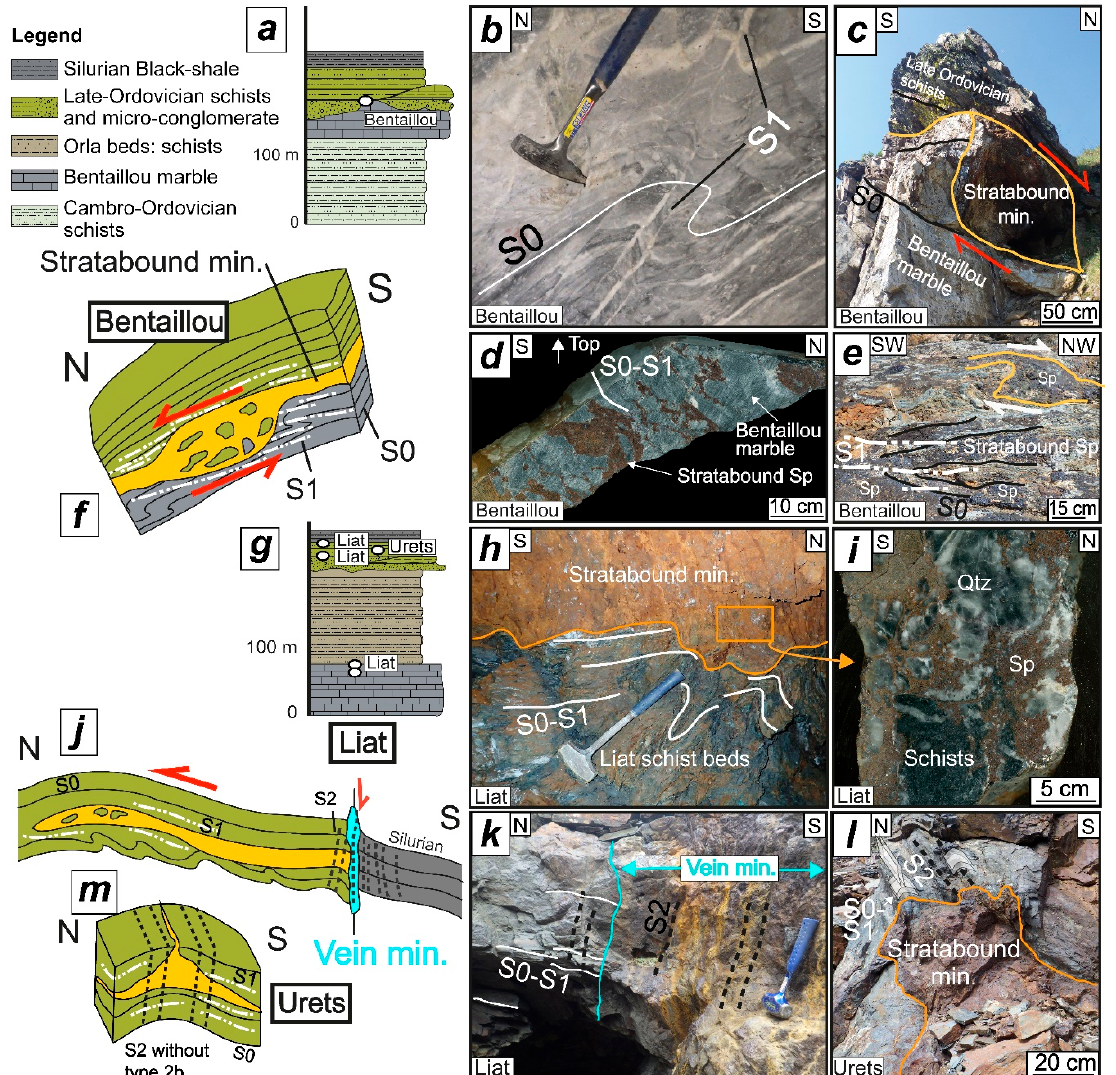
Figure 4. Field observation and structural models in the Bentaillou-Liat-Urets deposits (see location in Figure 3a). ( a ) Stratigraphic log of Bentaillou areas with position of the Pb-Zn deposits; ( b ) F 1 fold in Bentaillou marble with S 1 cleavage marked by calcite recrystallization; ( c ) pull-apart geometry of Pb-Zn mineralization in Bentaillou area; ( d ) oriented sample of typical mineralization in Bentaillou marble; and ( e ) relationship between sphalerite mineralization and host rock structure. Note that sphalerite is not folded by F 1 folds and intersect S0 stratification; ( f ) 3D structural model of Bentaillou deposits with Pb-Zn mineralization in cm to pluri-m pull apart geometry; ( g ) stratigraphic log of Liat-Urets area with position of the Pb-Zn deposits; ( h ) stratabound mineralization in top of folded schist beds in Liat area; ( i ) brecciated Pb-Zn mineralization in Liat area with clast of schist and quartz in sphalerite matrix; ( j ) 3D structural model of Liat deposit with dm to m stratabound and vein mineralizations; ( k ) vein Pb-Zn mineralization in Liat deposit; ( l ) stratabound mineralization in F 2 fold hinge in Urets deposit; ( m ) 3D structural model of Urets deposit with pluri-dm to m Pb-Zn mineralization in F 2 fold hinge. Mineral abbreviations: Qtz-quartz; Sp-sphalerite.